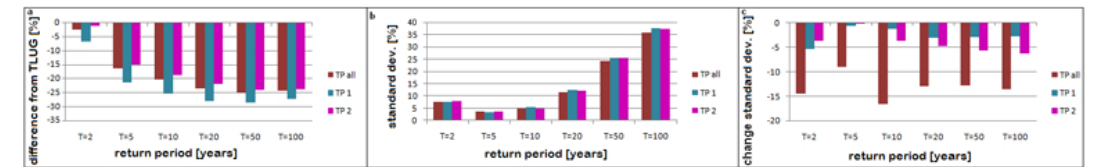
Fig. 5. (a–c) Results of uncertainty analyses; a: comparing own results in 6 annual flood return periods (means of 8 gauges, distributions with “ok” fit) with TLUG values in 3 time periods; (b) mean standard deviations of 6 annual flood return values (means of 8 gauges, distributions with “ok” fit) from mean in 3 time periods; (c) change in standard deviation of 6 annual flood return values (means of 8 gauges) when using only “well” fitted distribution in 3 time